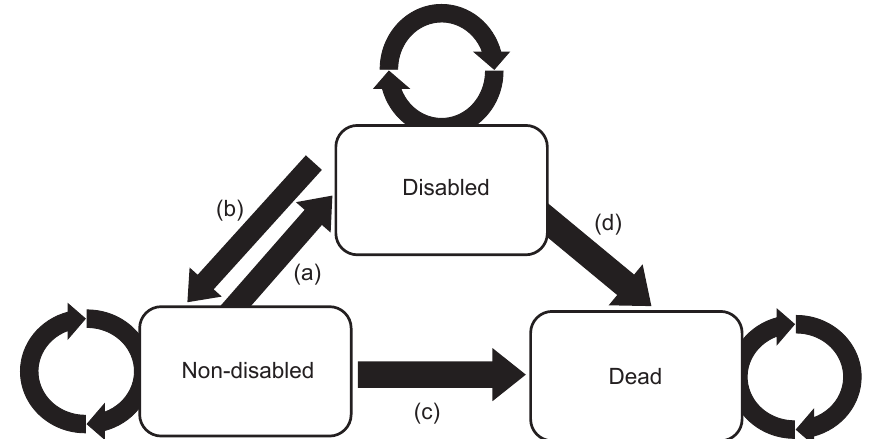
Figure 2. The Markov model (the multistate life table methods) applied in our study. In this scheme, three states (non-disabled, disabled, and dead) and four transitions over time were shown: that is (a) from non-disabled to disabled (an incidence of a disabled status), (b) from disabled to non-disabled (a recovery from a disabled status), (c) from non-disabled to dead, and (d) from disabled to dead. Each circulated arrows showed the retention